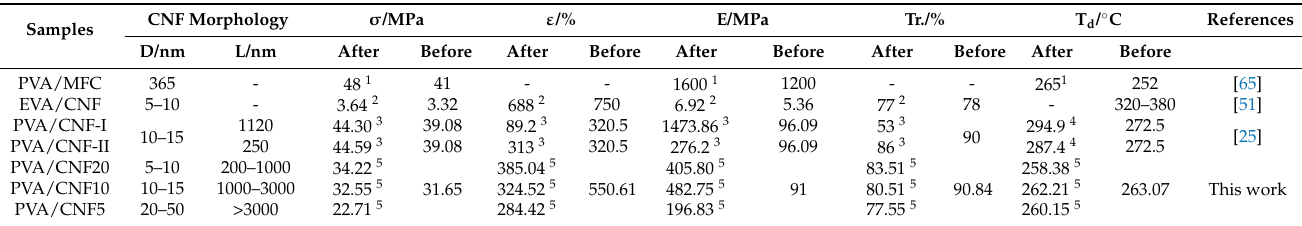
Table 5. The results of this work compared with other